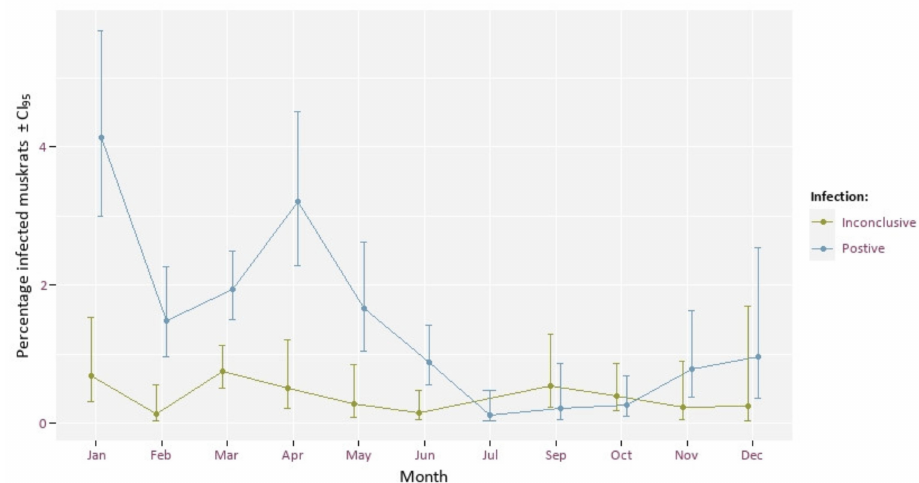
Figure 6. Percentage of muskrats with positive (blue) and inconclusive (green) EM presence by month.